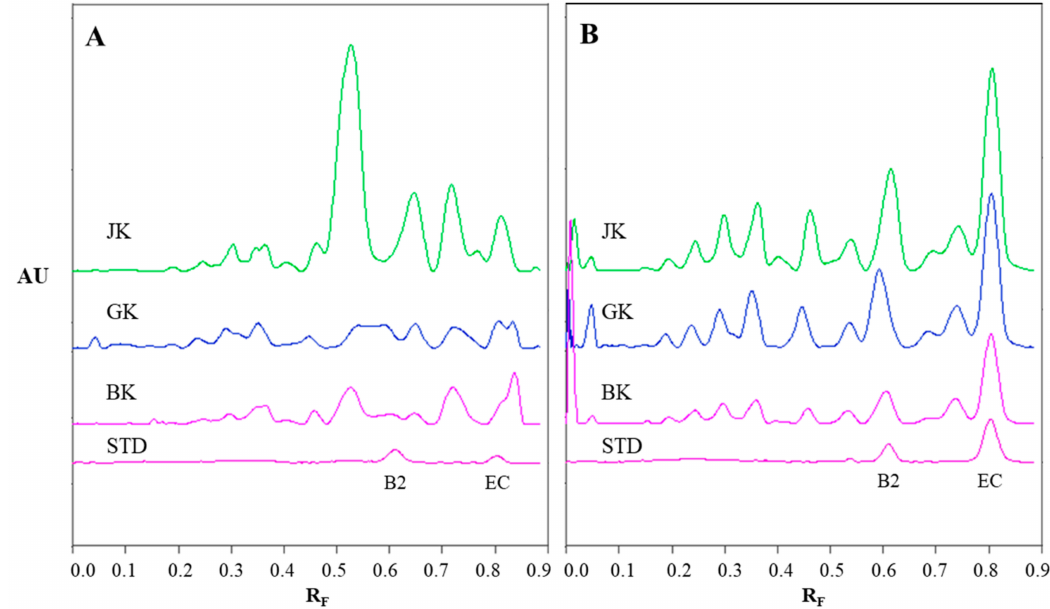
Figure 4. The densitograms of STSs (1 µ L, 50 mg/mL) from rhizomes of Japanese (JK), giant (GK) and Bohemian (BK) knotweed and standard solutions (STD, 40 ng) of ( − )-epicatechin (EC) and procyanidin B2 (B2) scanned in absorp- tion/reflectance mode at 280 nm before the derivatization ( A ) and at 655 nm after the derivatization with DMACA reagent ( B ). The HPTLC silica gel plate was developed with toluene–acetone–formic acid (3:6:1, v/v